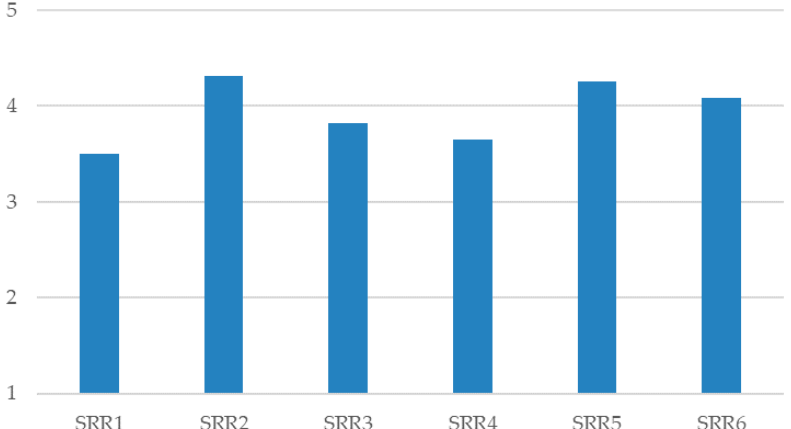
Figure 2. Values for situations in a relationship with risk of acts of violence. SRR = “Risk Situations in a Relationship”.